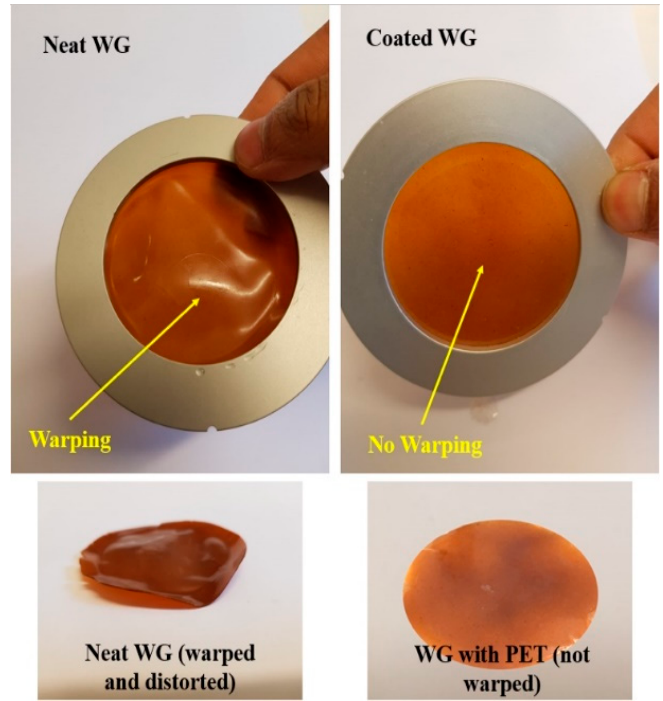
Figure 11. State of the neat and PET-layered WG film when exposed to saturated water vapor (100% RH) on the inside of the cup and 50% RH on the outside.